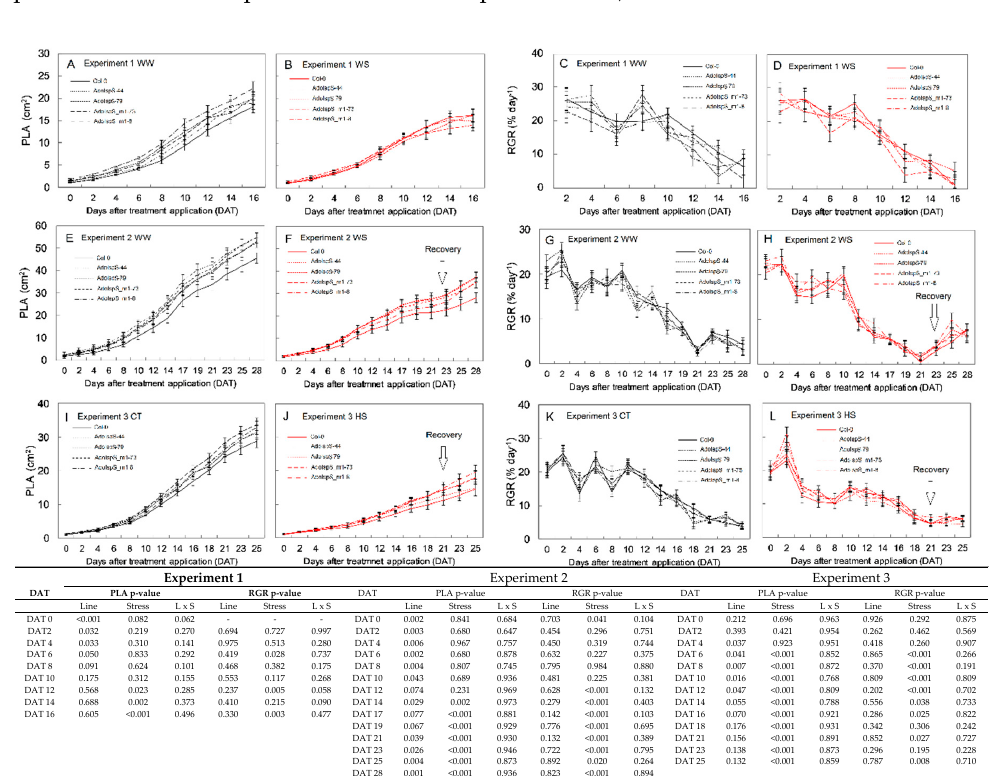
Correlations between PLA and shoot dry weight ( p < 0.001, R 2 = 0.84, data not shown) confirmed